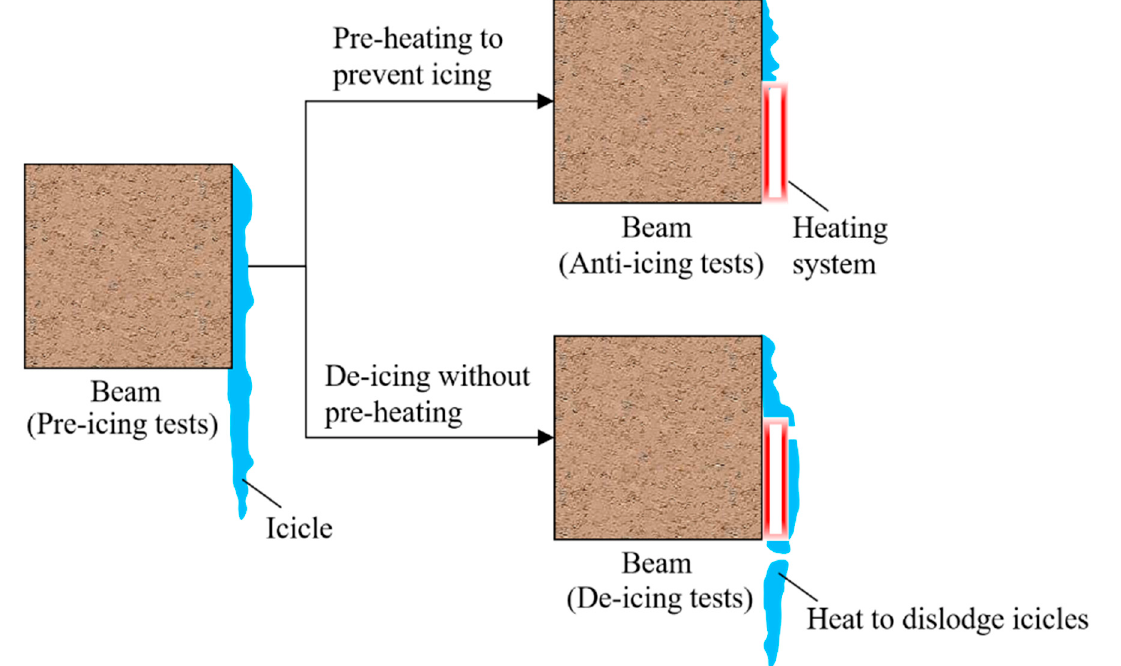
Figure 1. Schematic diagram of the de-icing test idea of the beam.